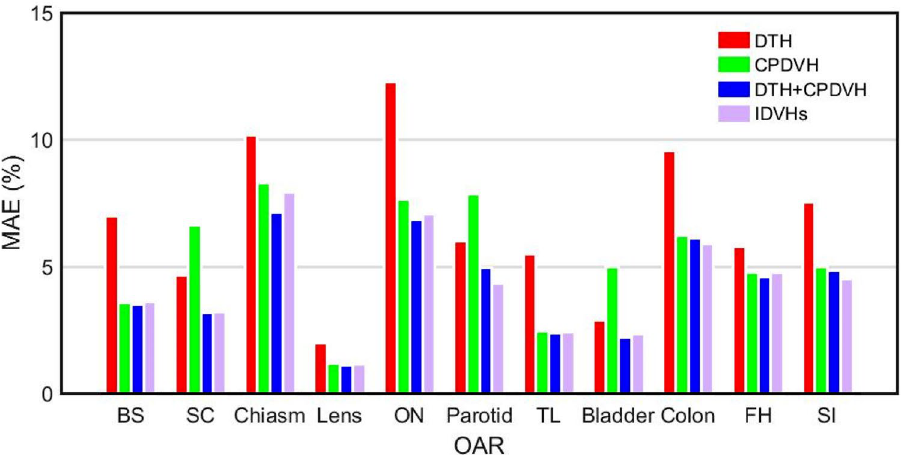
Figure 4. The mean MAE of different prediction methods. BS brainstem, SC spinal cord, ON optic nerve, TL temporal lobe, FH femoral head, SI small intestine.